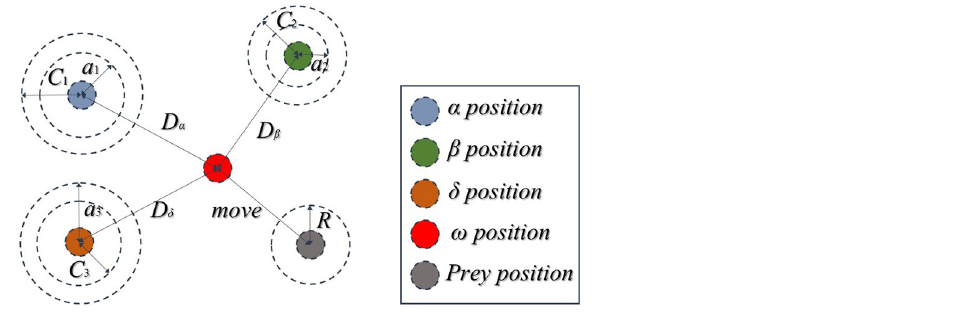
Figure 10. Position updating in